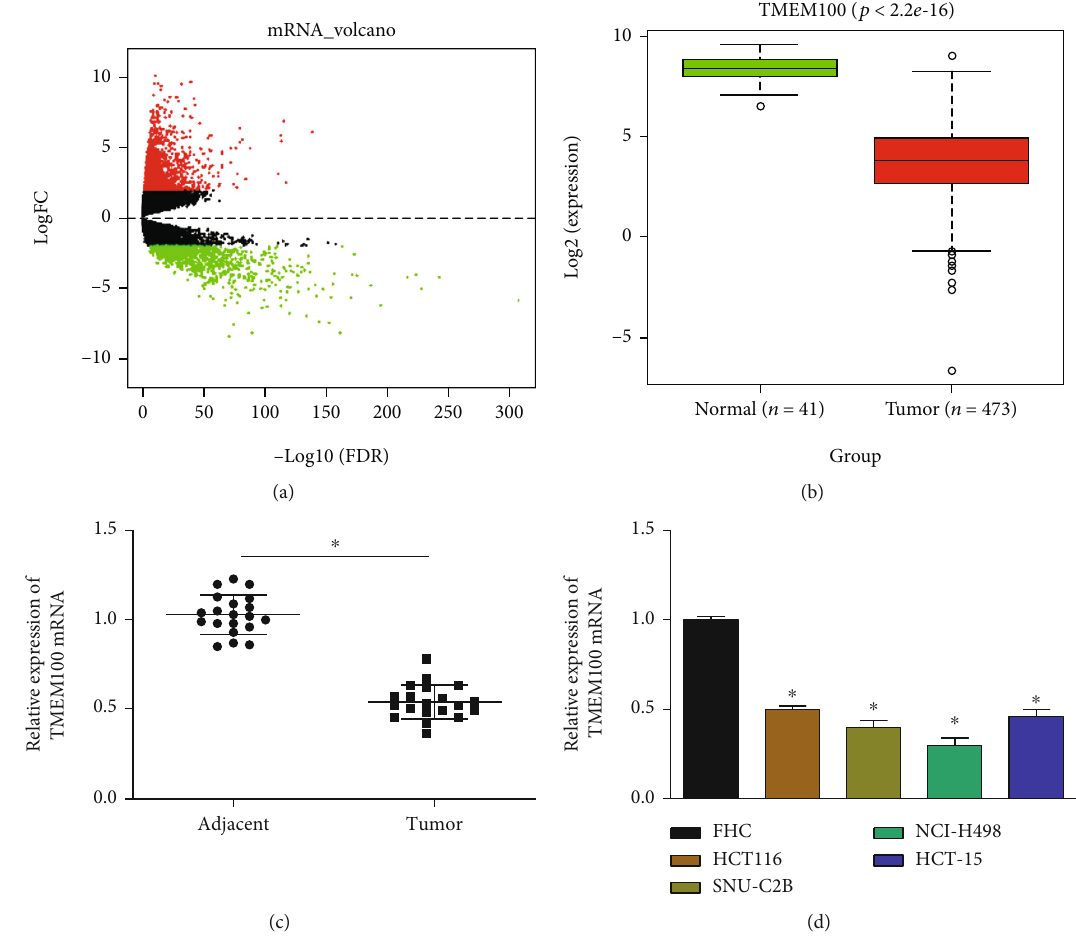
Figure 1: TMEM100 expression is decreased in CRC tissue and cells. (a) Volcano plot of DEmRNAs. Red for highly expressed genes, and green for lowly expressed ones. (b) Relative expression of TMEM100 in the normal group and tumor group. (c) qRT-PCR determined the TMEM100 expression in the tumor and normal samples. (d) TMEM100 expression in normal human colorectal cells and CRC cells. ∗ p < 0 : 05